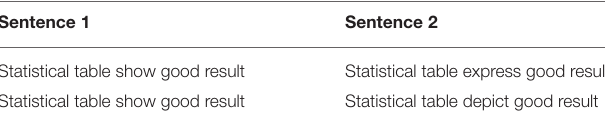
Statistical table express good result Statistical table show good result Statistical table depict good